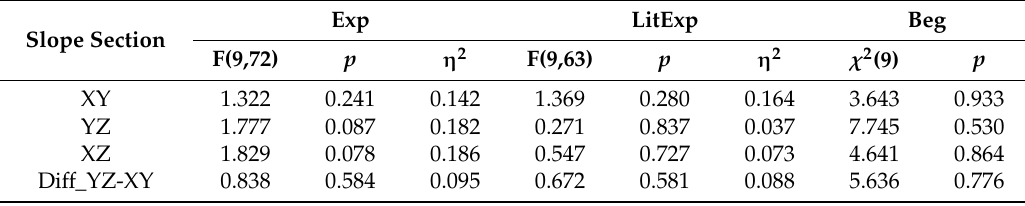
Table 2. Intraindividual slope in the linear section. Results of statistical tests (RM ANOVA for Exp and LitExp; Friedman test for Beg) analyzing the slope in the linear section XYZ between the 10 repetitions within each group Exp, LitExp and Beg, respectively. Given are the test statistics F or χ 2 , significance p and e ff ect size η 2 for RM